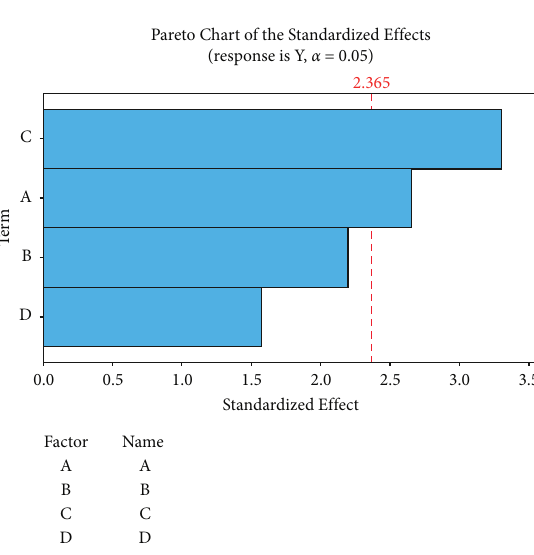
Figure 1: Analysis chart of factor screening Pareto. Table 2: CCD experimental program and response